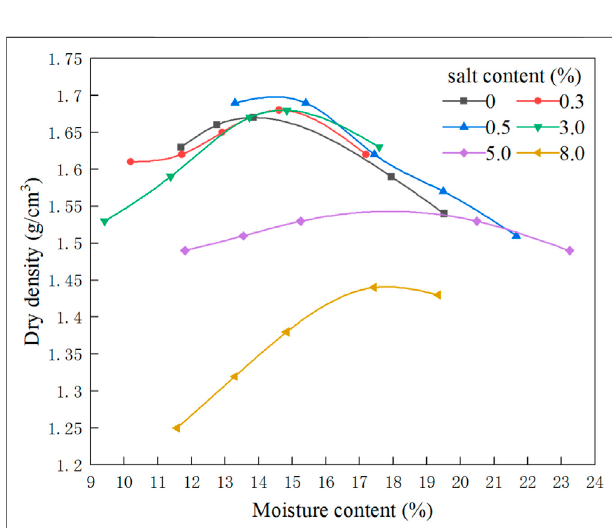
FIGURE 4 | Compaction curve of sulfate soil with different sulfate